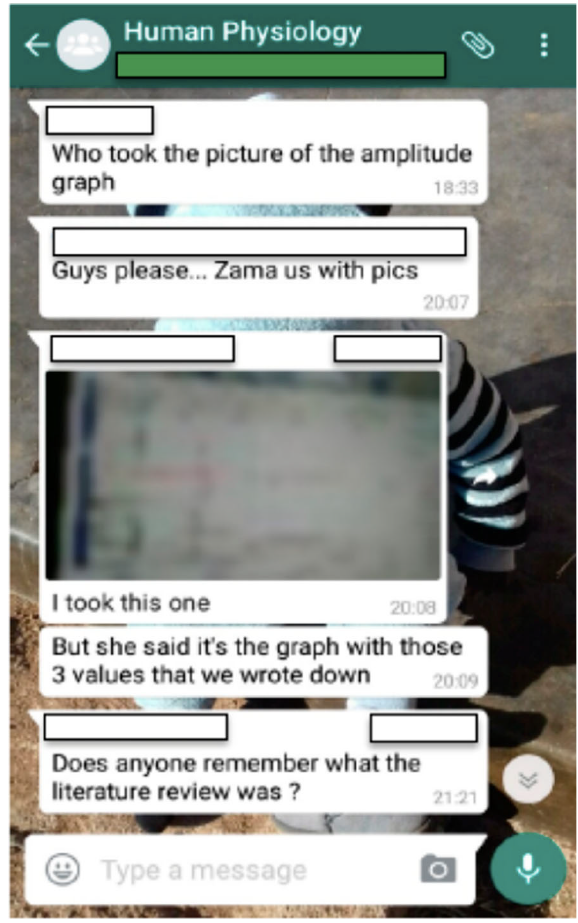
Figure 2: WhatsApp group studying conversation (Evernote entry, reproduced with permission from the